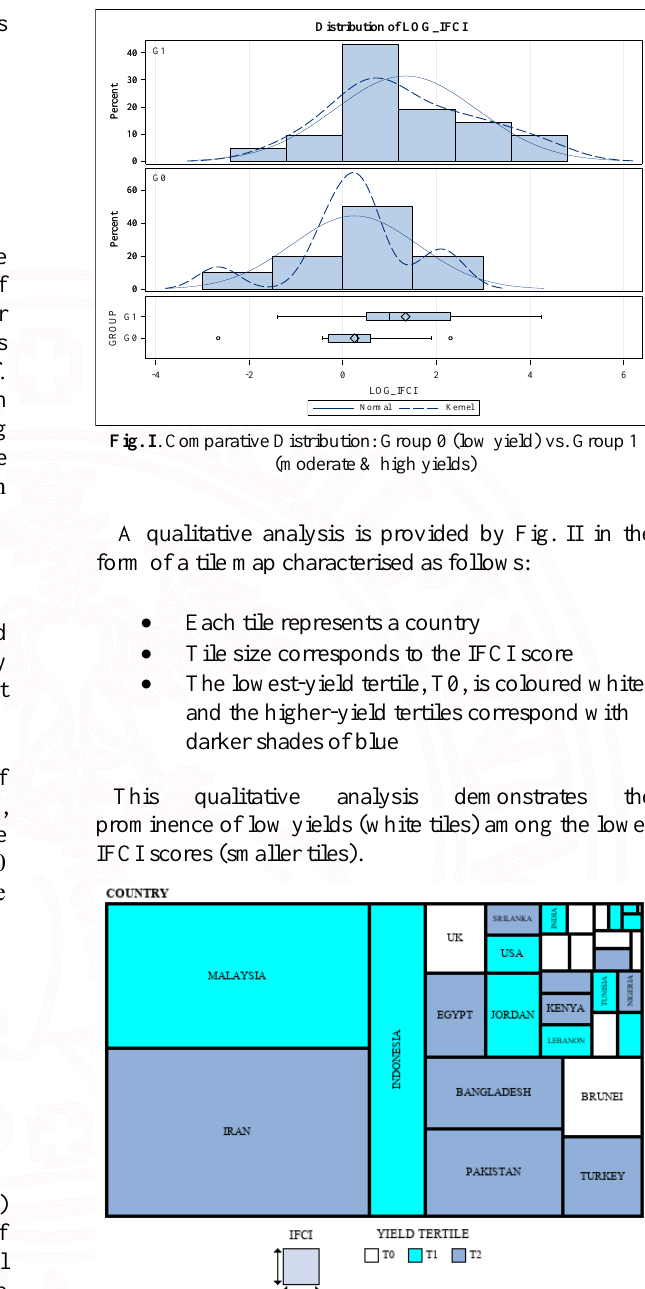
Fig. II . Tile map of the IFCI scores by countries/yield-based colouring